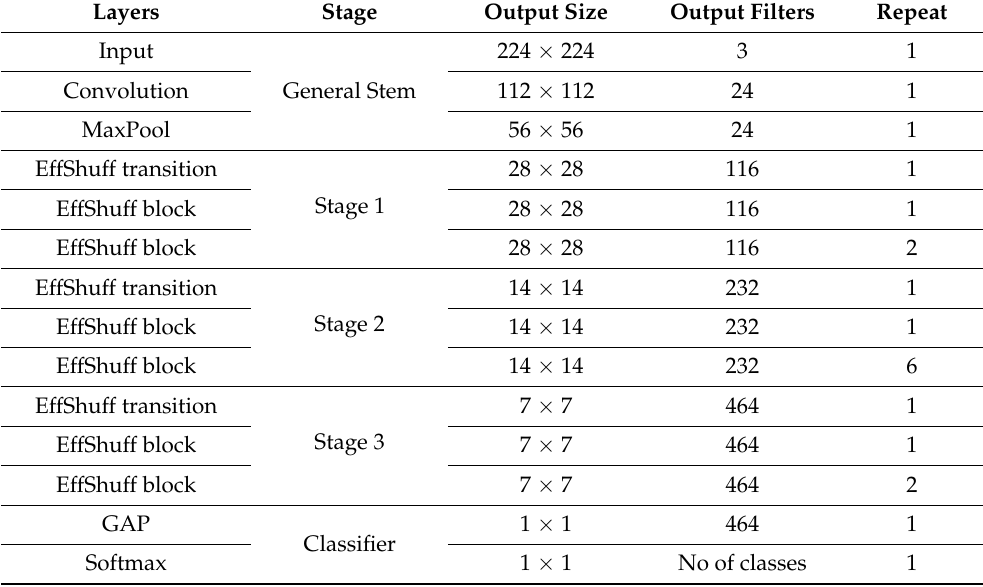
Table 1. EffShuffNet